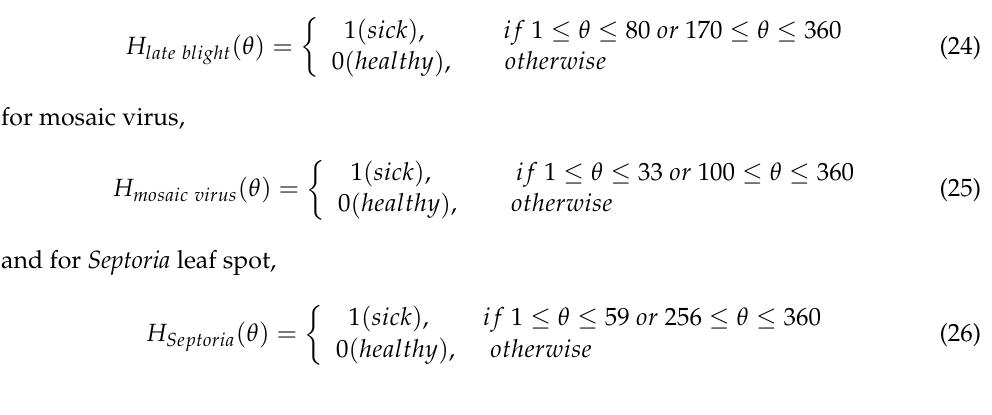
Figure 5. Color range of pixels representing healthy and diseased areas on a late blight leaf (hue component). In this way, the hue component of the HSV color model is thresholded using the values assigned by the expert in the area of phytopathology for each of the diseases, obtaining the thresholding function to locate late blight as,